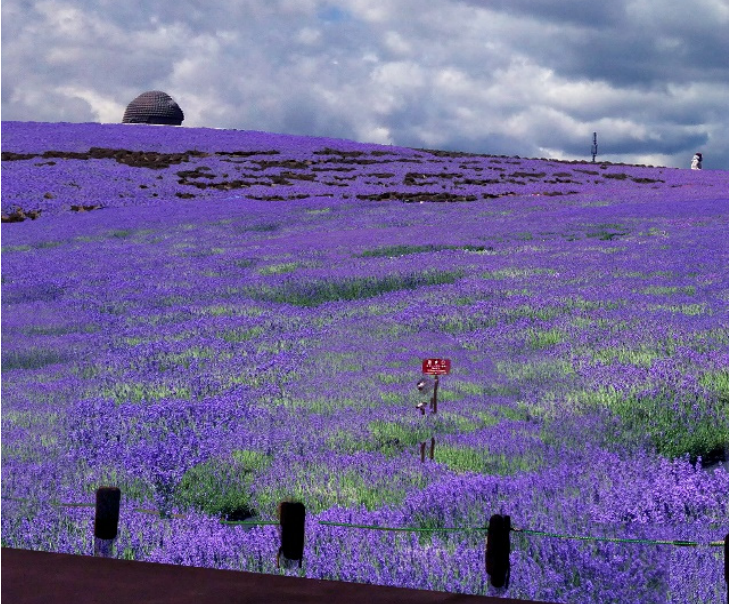
Figure 30. Tadao Ando, Hill of the Buddha (2017), with Buddha’s Head emerging from a field of lavender shrubs, at Makomanai Takino Cemetery (Sapporo).